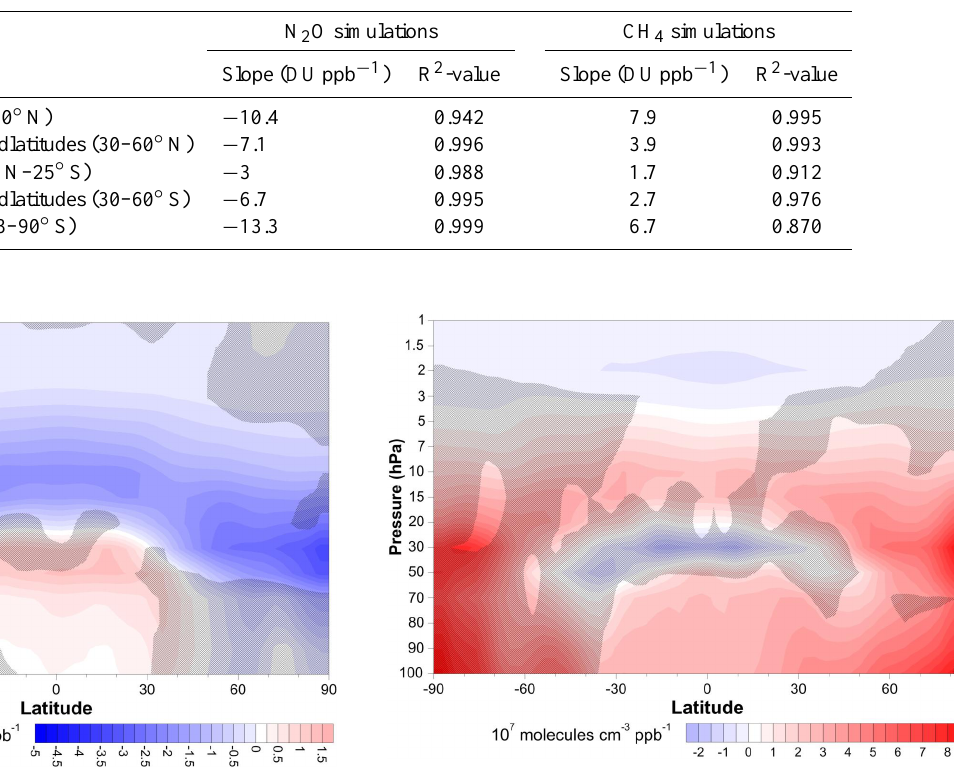
Figure 9. Slopes from simple linear regression models fitted to 2090s-mean ozone vs. 2090s-mean surface N 2 O for all latitudes and all pressure levels between 1-100 hPa, for the four N 2 O simulations. Hatching indicates that the slope was not statistically significantly different from zero at the 95% level of confidence.